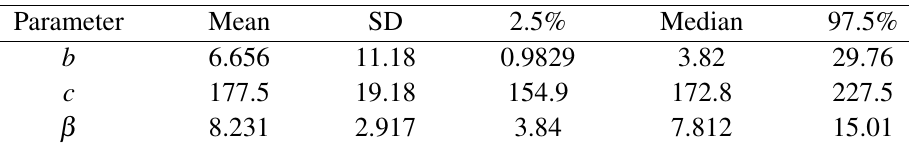
Table 1. Results of the Bayesian approach to the Kum-IW